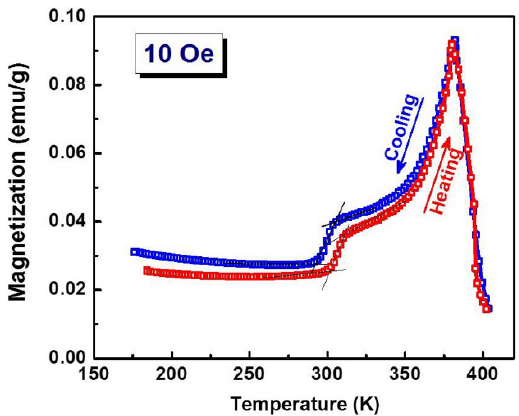
Figure 2. Magnetization versus temperature ( M - T ) curves for Ni Mn Ga Fe 48 26.4 19.7 5.9